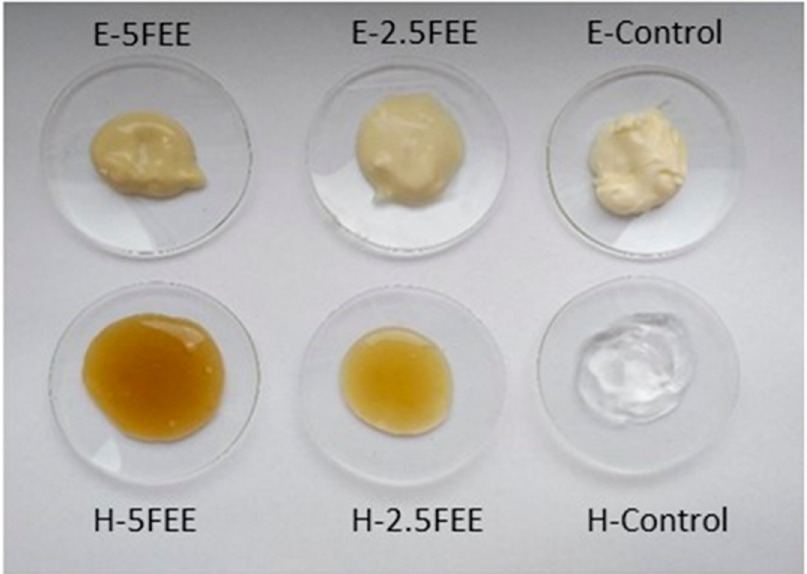
Table 5. Compositions of the prepared hydrogels and emulsions used in the penetration study.